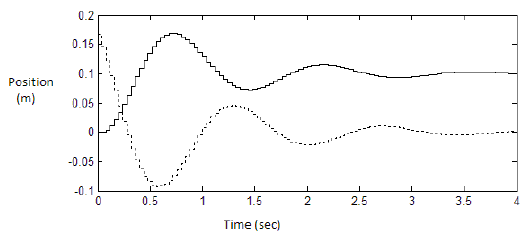
‐0.050 ‐0.05 Figure 28: Step response for linear P‐D control Figure 28: Step response for linear P‐D control Figure 27. Experimental step response for linear PD control.